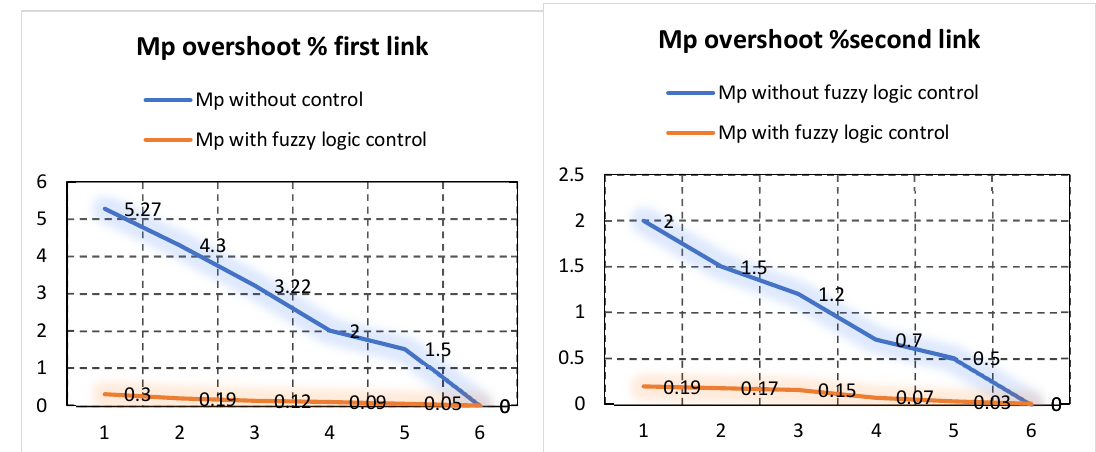
A- overshoot of vibration of first link. B- overshoot of vibration of second link. Fig. 13. Comparisons of maximum overshoot of the two links with and without fuzzy logic